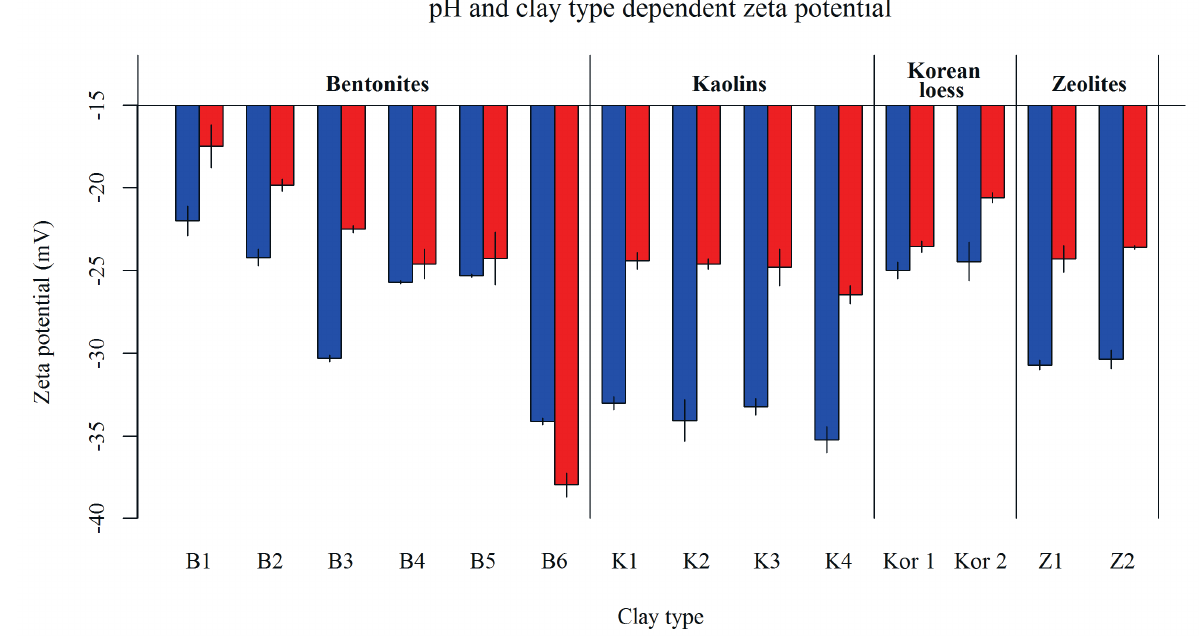
Figure 6. Zeta potential (mV) of different clay types in L-15/ex medium at pH 7 (blue bars) and pH 9 (red bars).